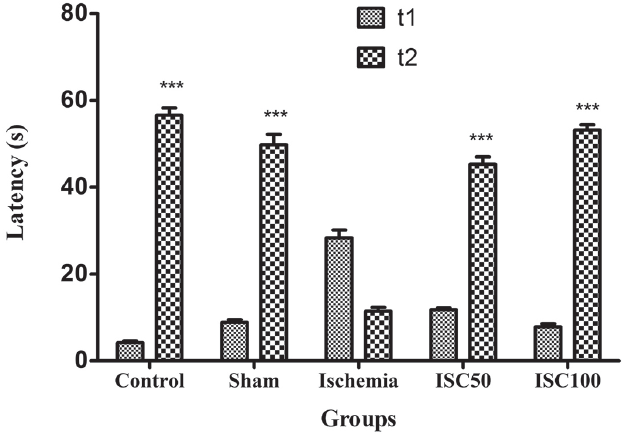
FIGURE 2 - The effect of A. italica extract on passive avoidance memory in shuttle box test on hippocampal injury induced by transient global cerebral ischemia and reperfusion. t1: the primary latency to enter the dark room and t2: the latency during passing. ISC 100 and ISC 50: treated with 100 and 50 mg/kg of Anchusa italica extract, respectively. (***: significant difference between the all groups with ischemia group, P < 0.001). The number of samples,